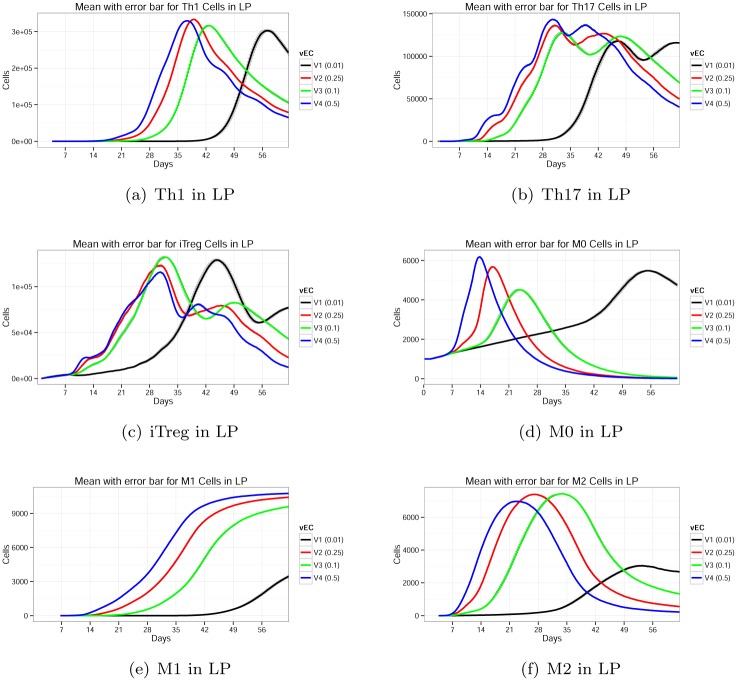
Effect of parameter v
EC on Th1, Th17, iTreg, M0, M1, and M2 phenotypes.